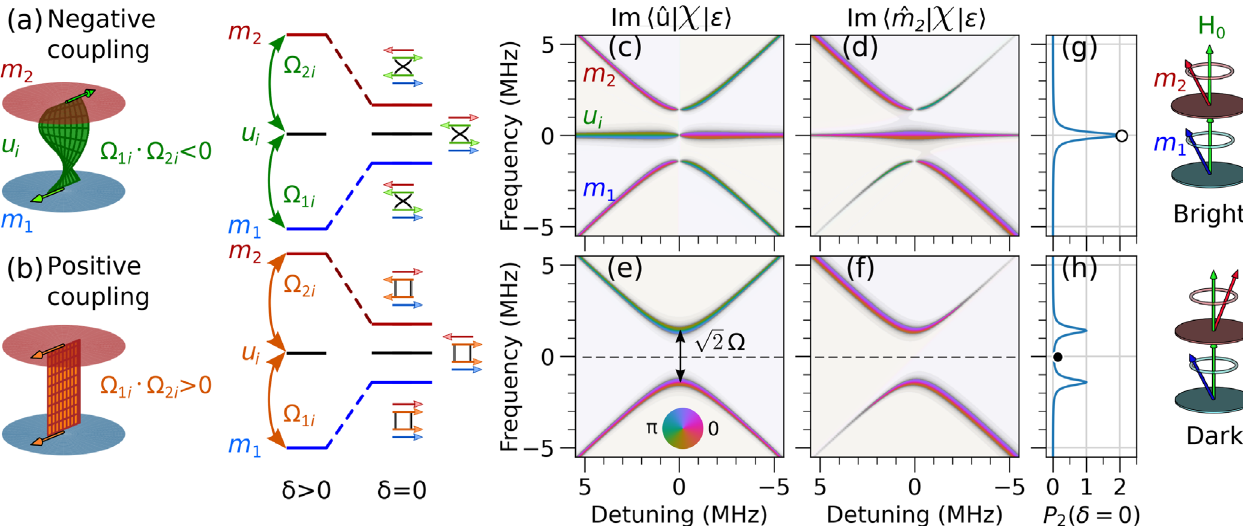
þ ω Þ = 2 ¼ ω 1 2 i